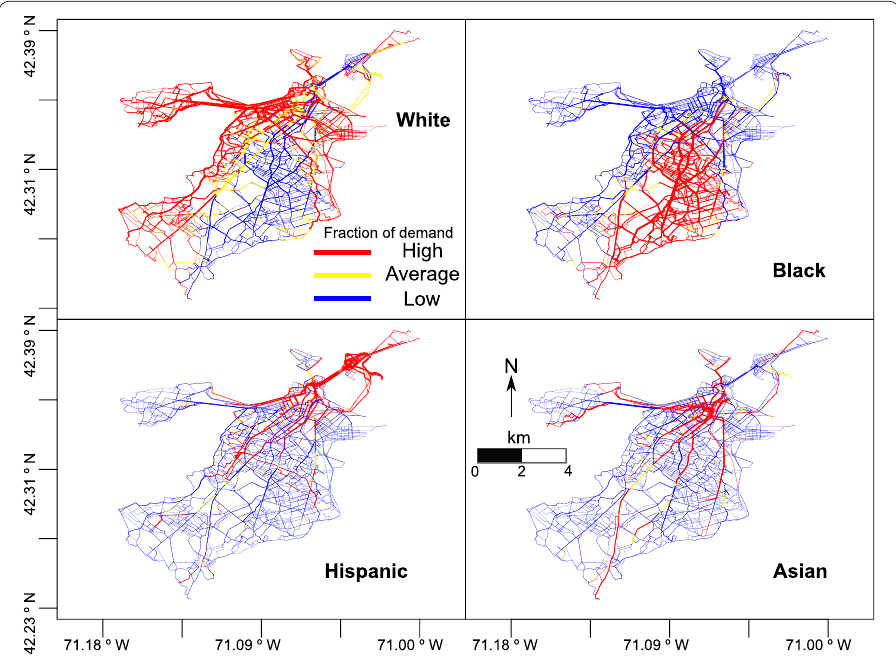
Fig. 2 Each image represents the street network demand for each group, with edges colored based on each group fraction of demand and width representing each group’s demand on the edge. Red indicates that the fraction of demand is higher than 1.14 times the global demand fraction for the group, blue indicates that the fraction of demand is lower than 0.87 times the global demand fraction for the group, and yellow indicates the region in